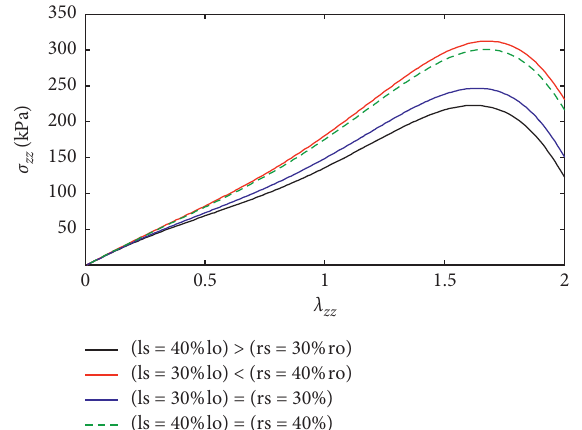
Figure 8: Comparative study of the deposition of plaque on the axial stress.